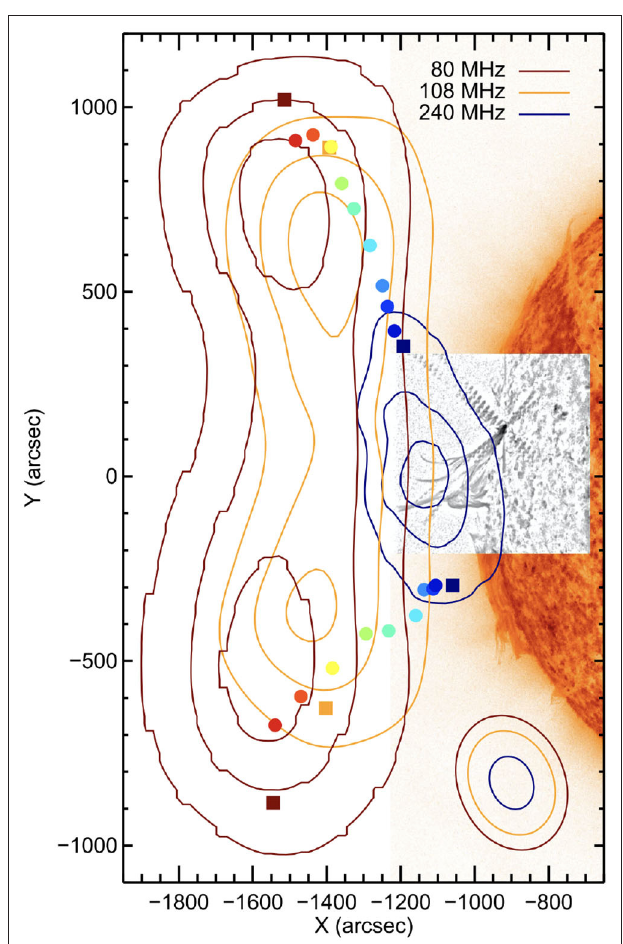
FIGURE 4 | MWA contours at 20, 50, 80 % peak flux of a type III burst following a splitting magnetic connectivity above a EUV jet. The background jet structure is highlighted in black and white, over the 304 Angstroms Sun. From McCauley et al.